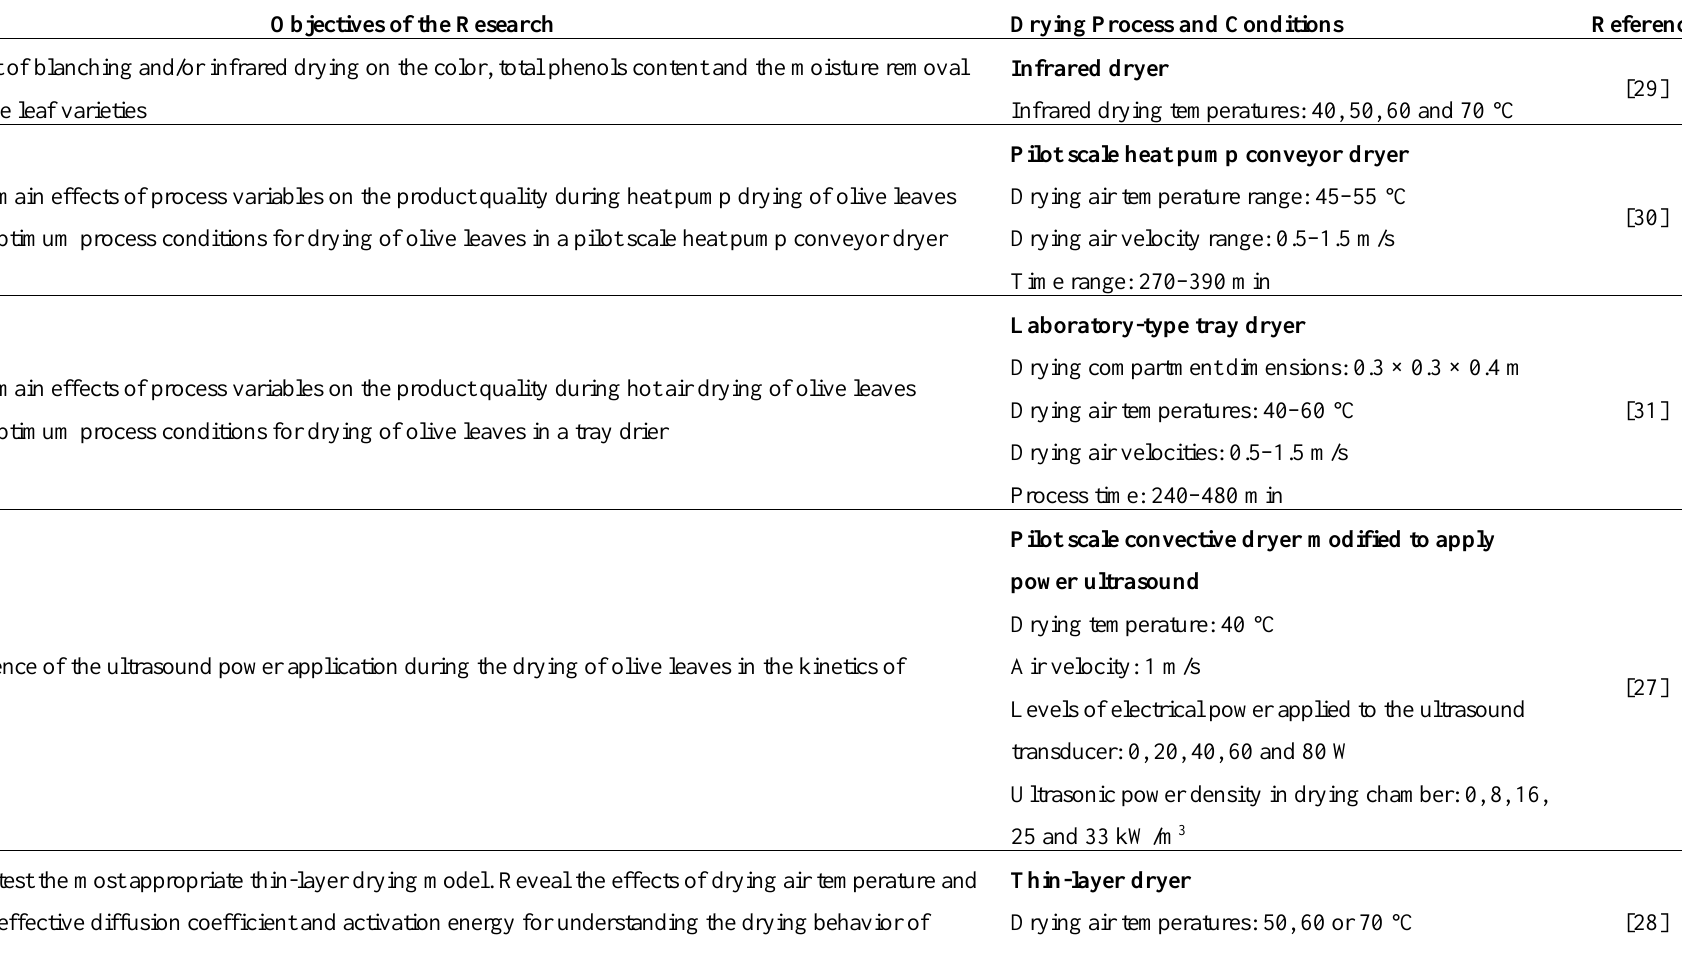
Table 1. Drying process for olive leaf